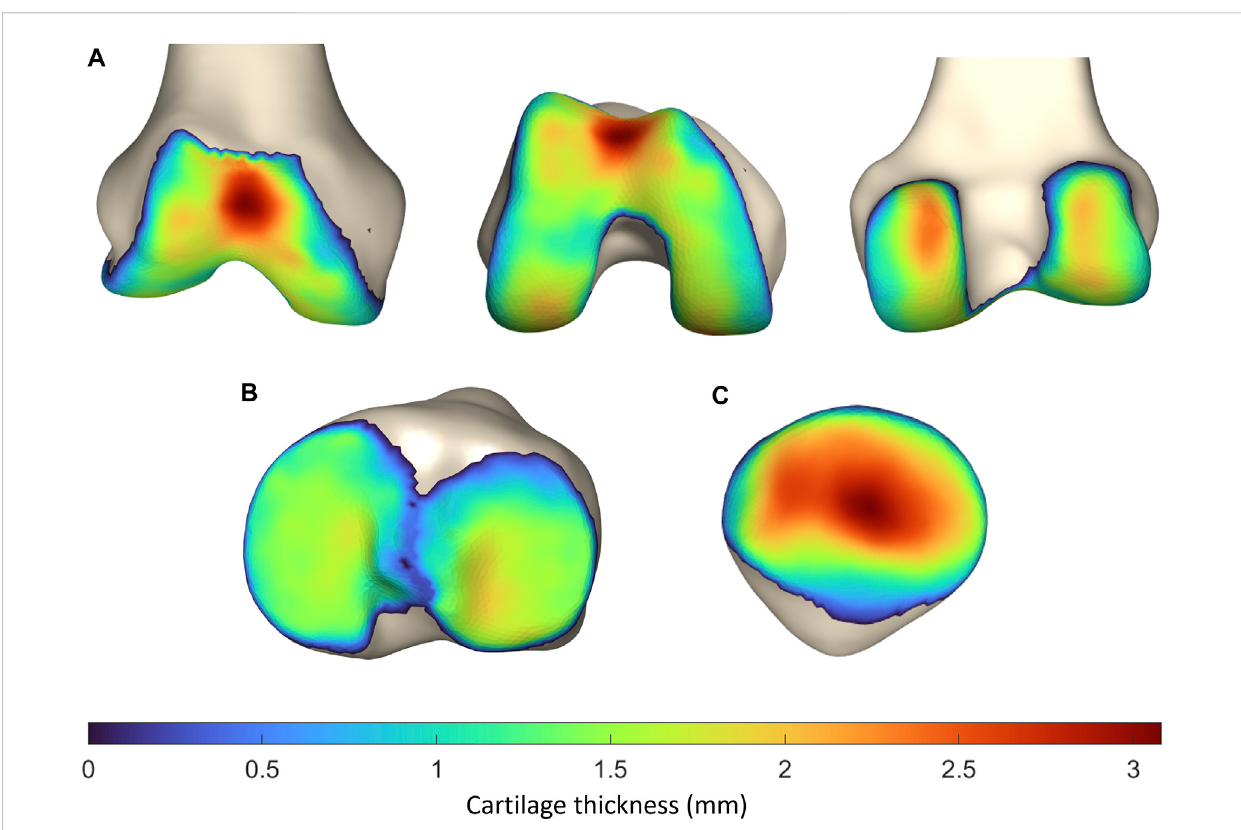
FIGURE 9 Representationofthevertex-speci fi ccartilagethicknesson (A) themeanfemur, (B) themeantibiaand (C) themeanpatella,extractedfromtheSSM. The average cartilage thickness ranges from 0 mm (blue) to 3.23 mm